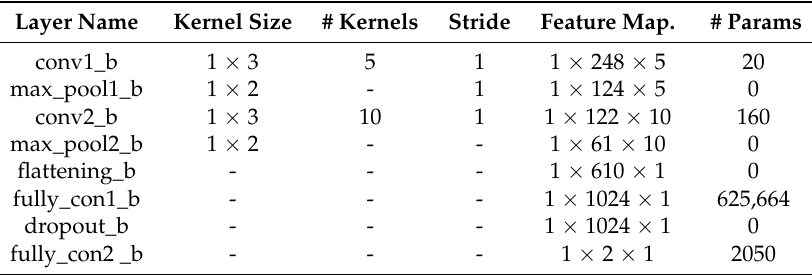
Table 2. Details of the CNN architecture b .